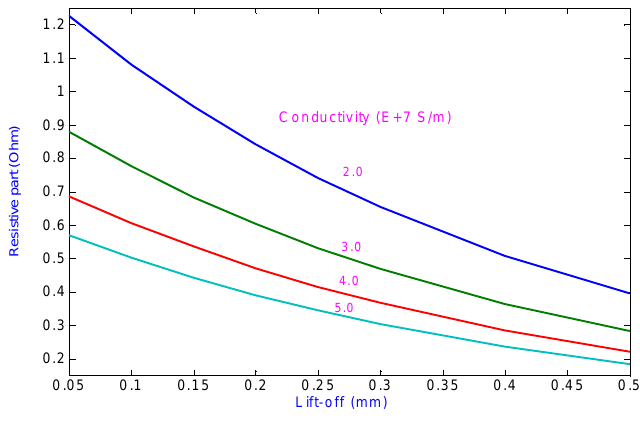
Figure 20. Variation of the real part of transfer impedance with lift-off at 500 kHz.